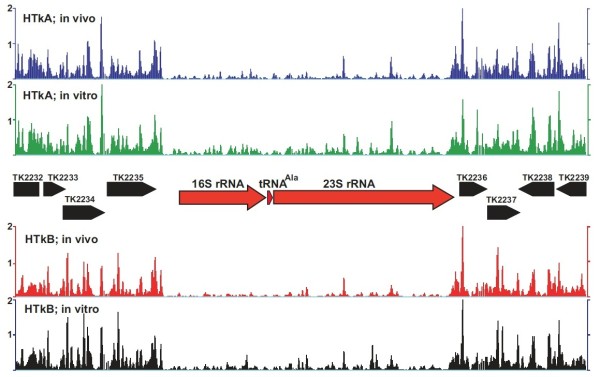
Archaeal nucleosomes do not assemble on the ribosomal DNA operon. Profiles of the archaeal nucleosomes assembled by HTkA and HTkB in vivo in T. kodakarensis LC125 and LC124, respectively, and in vitro on a 10 Kbp region of the T. kodakarensis genome. As illustrated, this region encodes the 16S and 23S rRNA (rDNA operon; red arrows) and several protein-encoding flanking genes [34,39].